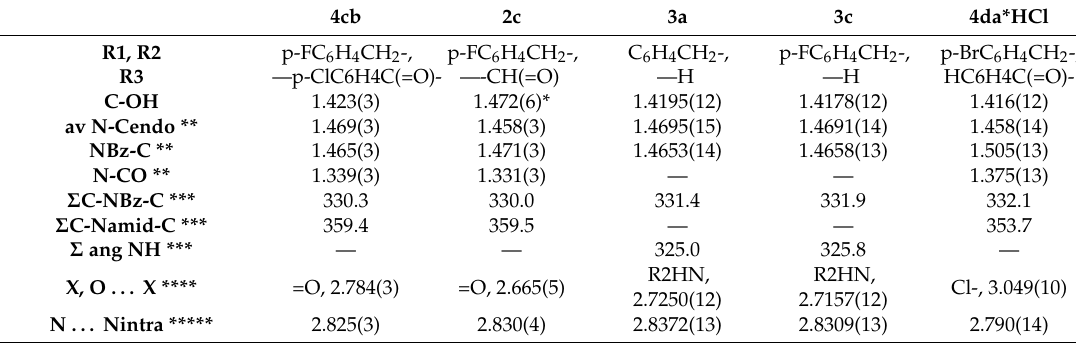
Table 1. Selected geometric parameters for bispidines 4cb , 2c , 3a , 3c , 4da